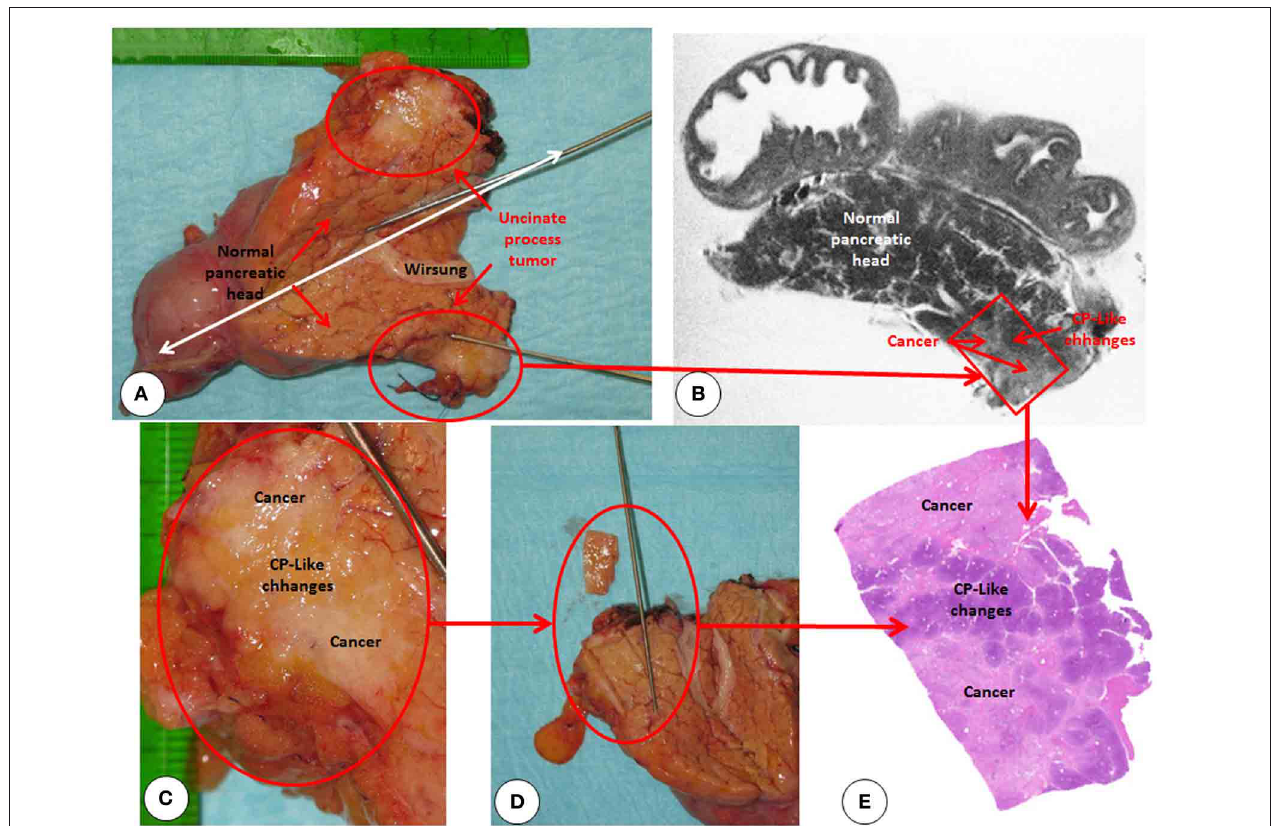
FIGURE 8 | Correlation of postoperative high resolution T2 weighted magnetic resonance imaging with microscopic findings. (A) The resected pancreatic head is cut open along the white double headed arrow. Red circle marks the desmoplastic uncinate process tumor. (B) High resolution ex vivo T2 weighted imaging of the resected specimen using magnetic resonance imaging showing high fidelity of the macroscopic texture. However the